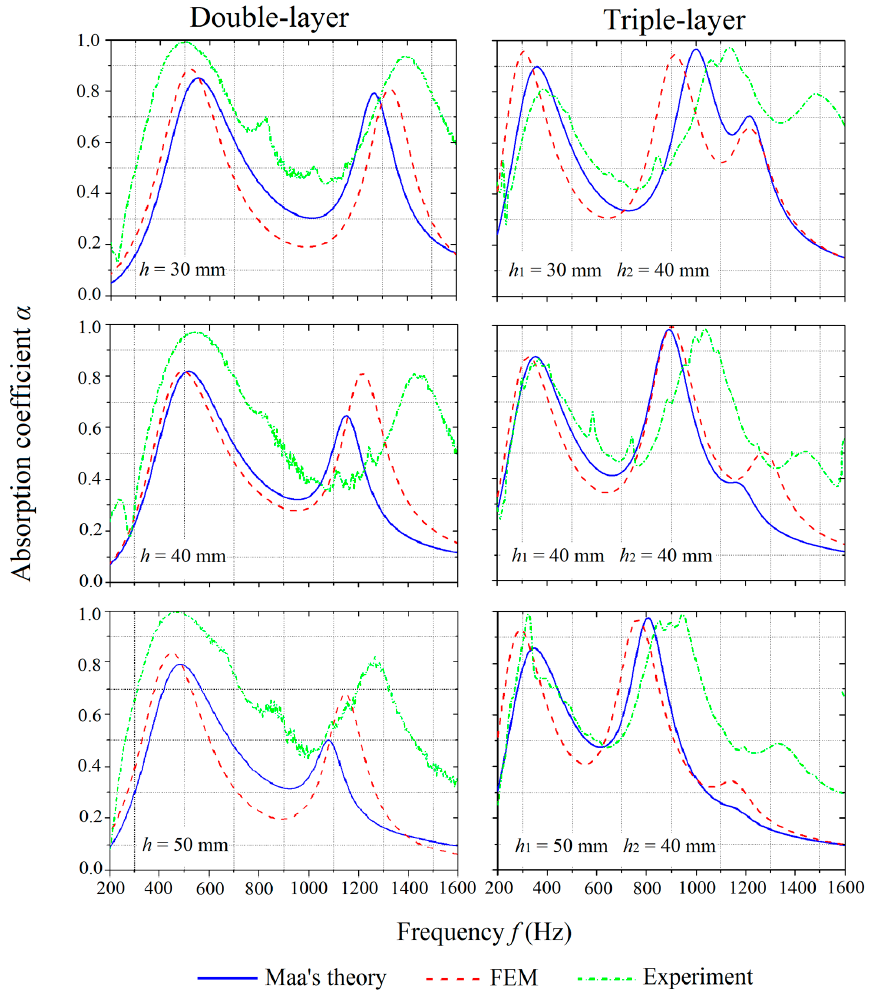
Figure 8. Comparison of absorption coefficients of the MPPs with varying inter-layer distances obtained by the theoretical predictions, numerical simulations, and experiments.